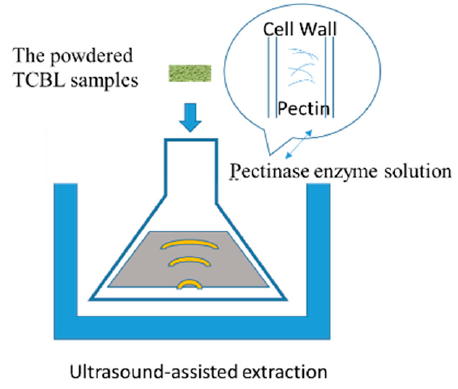
Figure 1. Enzyme and ultrasound-assisted coupled extraction.